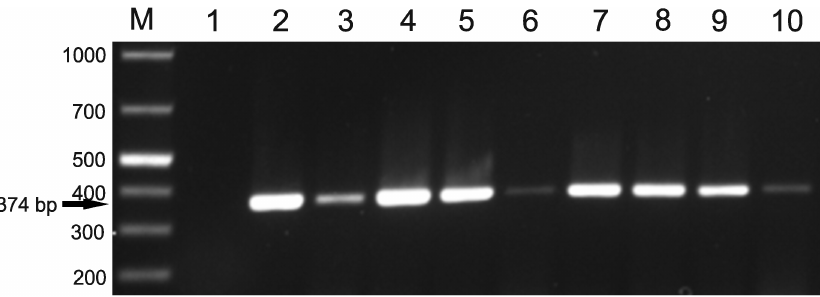
Fig 3. Detection of PvEV-1 by RT-PCR in common beans in Tanzania. In the list below,landraces are marked with asterisk ( * ).Other samples representimprovedvarieties(originof samplesshown in parenthesis). Lanelabelled‘M’ represents a O’GeneRuler 1 kb Plus DNA ladder.The expectedsize of PCR products was 374 bp. Lanes1, ‘Njugu’ * (SouthernHighlandszone); 2, ‘pooledRNA’ (Southern Highlands zone); 3, ‘pooled RNA’ (Eastern zone); 4, ‘pooledRNA’ (Northernzone); 5, ‘Rosekoko’/’Lyamungu85’ (Eastern zone); 6, ‘Salundi’ (Southern Highlandszone); 7, ‘E 36’ (SouthernHighlandszone); 8, ‘Msafiri’ * (Southern Highlands zone); 9, ‘Msafiri’ * (Eastern zone); and 10, ‘Mshindi’ (Eastern zone).